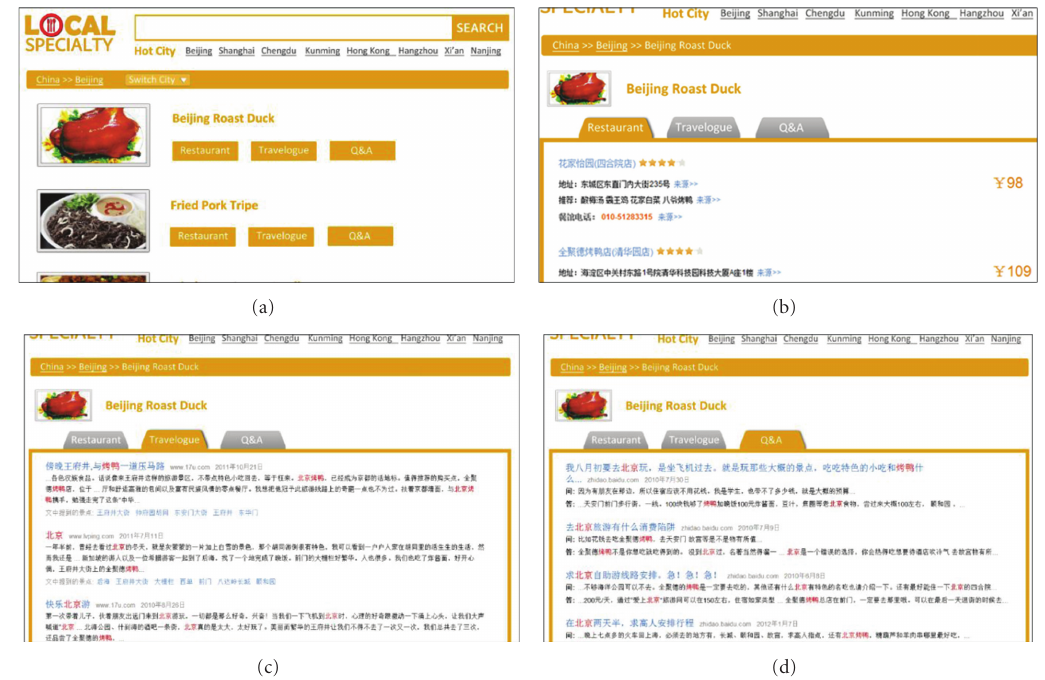
Figure 4: Local specialty recommendation service. (a) City’s local specialties. (b) Dish’s-associated restaurants. (c) Dish-associated trave- logues. (d) Dish associated Q&A threads.